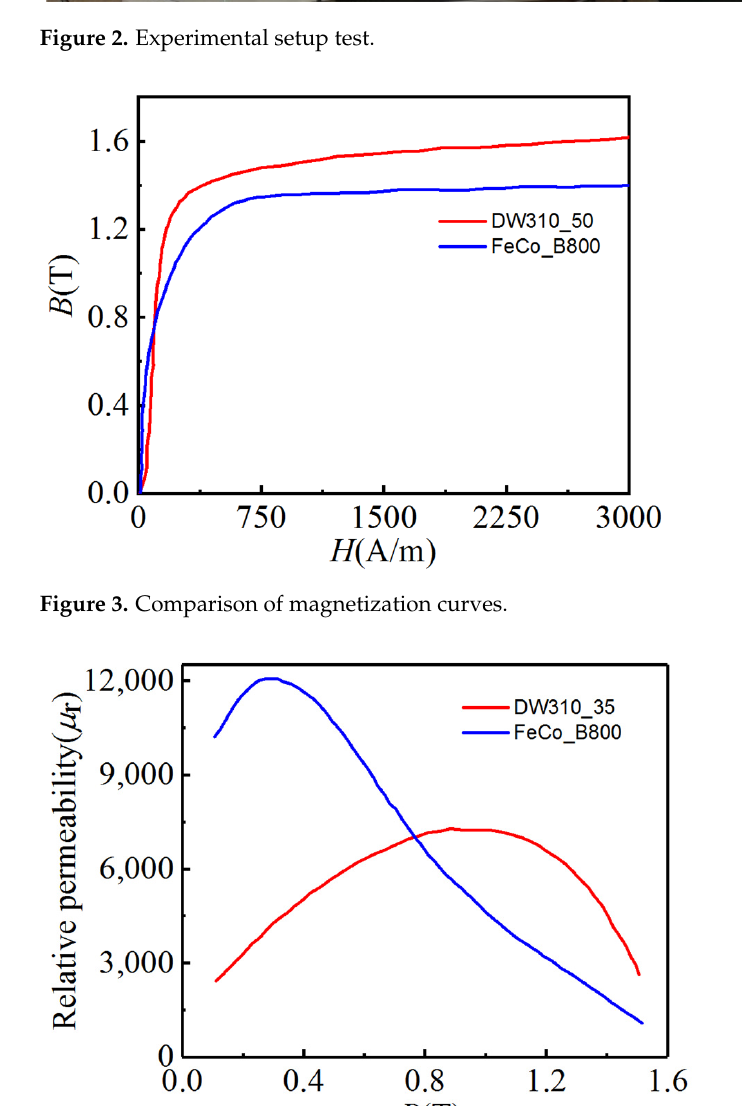
Figure 3. Comparison of magnetization curves. Figure 4. Comparison of relative permeability curves.